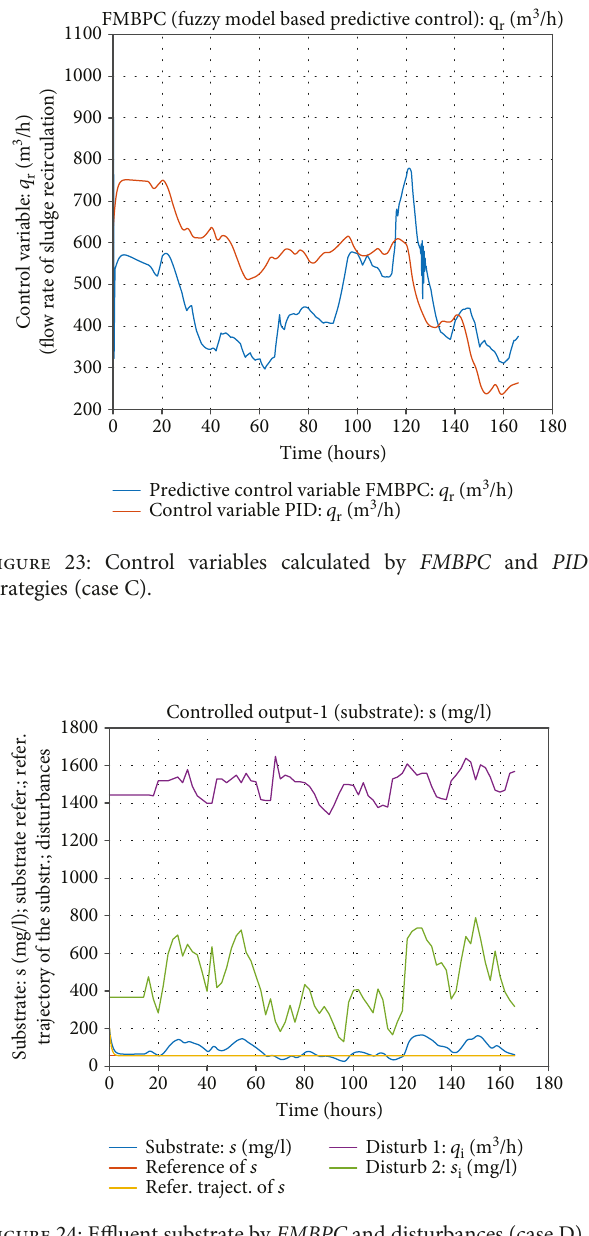
Figure 24: E ffl uent substrate by FMBPC and disturbances (case D).